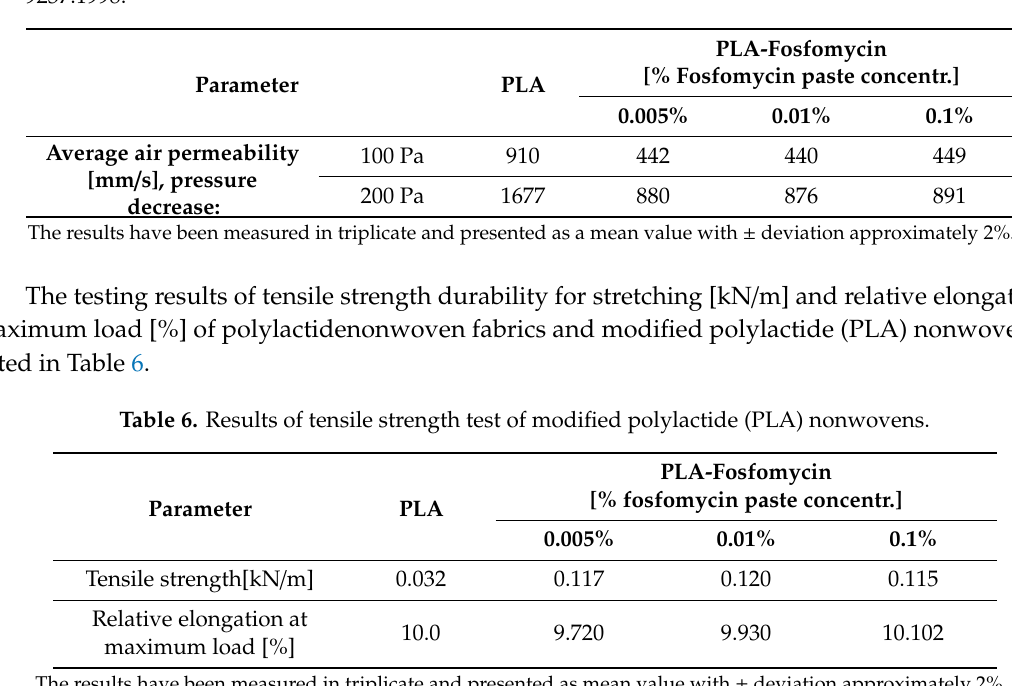
Table 5. The air flow resistance of modified polylactide (PLA) nonwovens, according to: EN ISO 9237:1998.